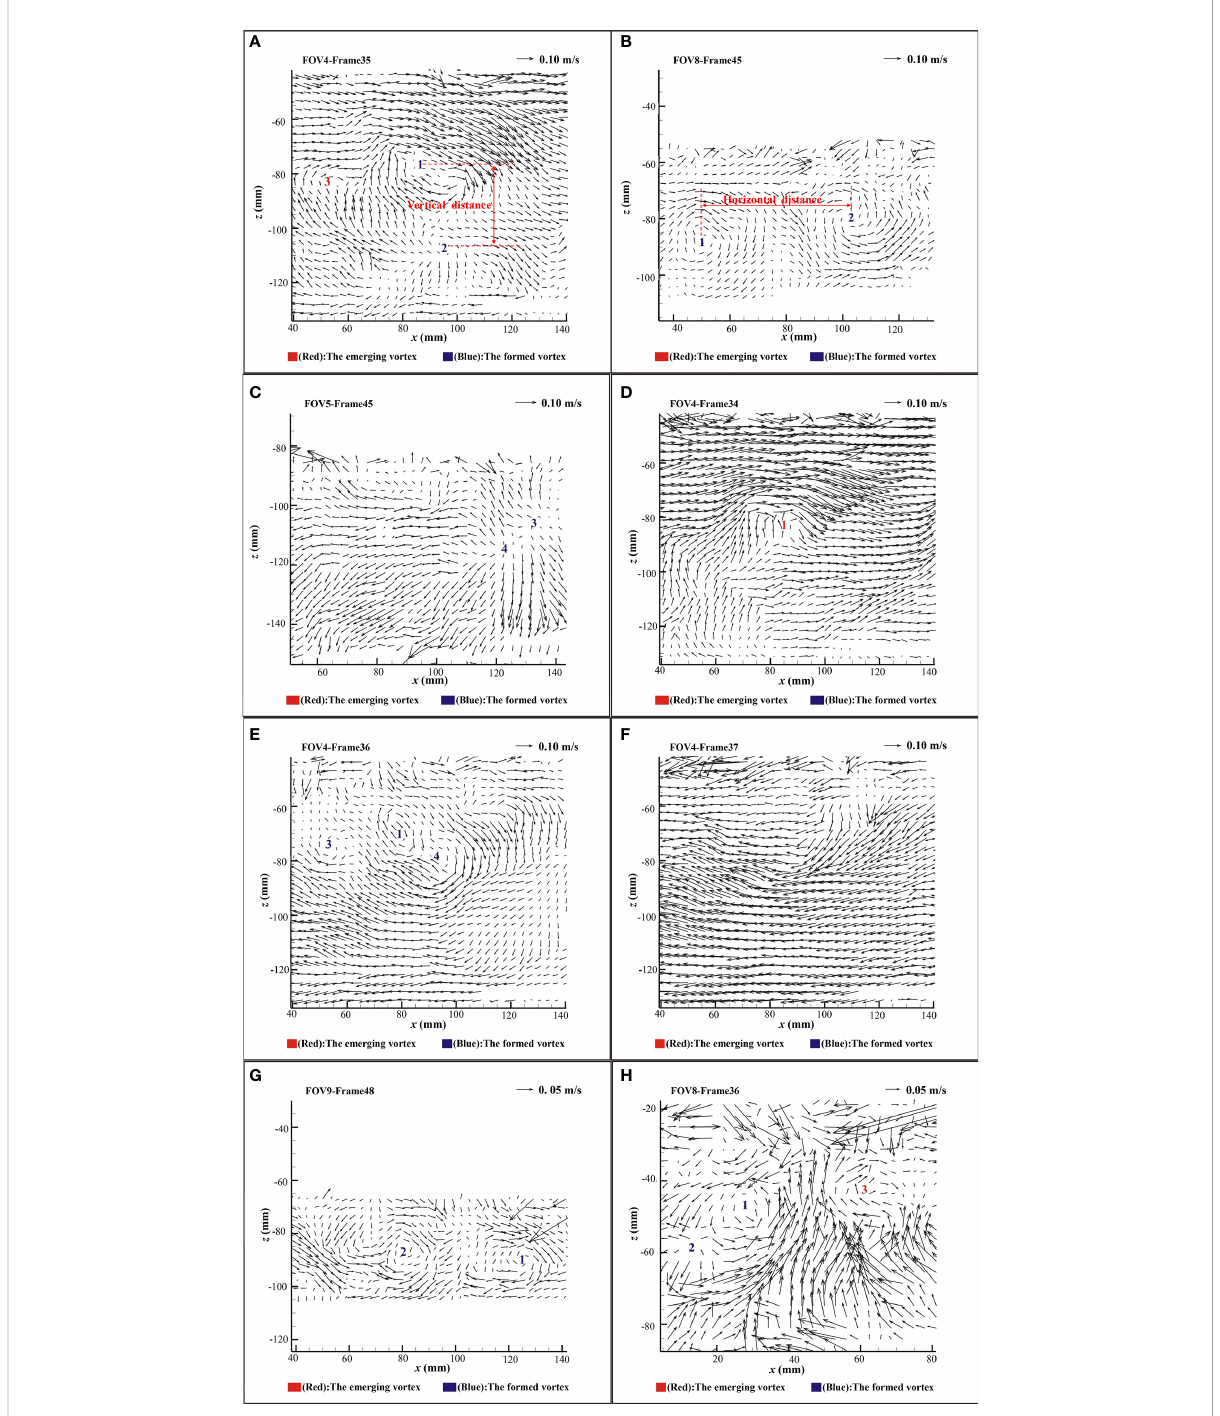
FIGURE 11 Vortex structures at different PIV windows. (A) SPV (indicated by “ 1 ” ) and OPSV (indicated by “ 2 ” ) on the steep beach. (B) SPV and OPSV on the composite beach. (C) Downburst structure on the composite beach. (D – F) Formation and evolution of vortices in FOV4 (steep beach). (G) A different vortex structure coexists in a frame on the mild beach. (H) A different vortex structure coexists in a frame on the steep